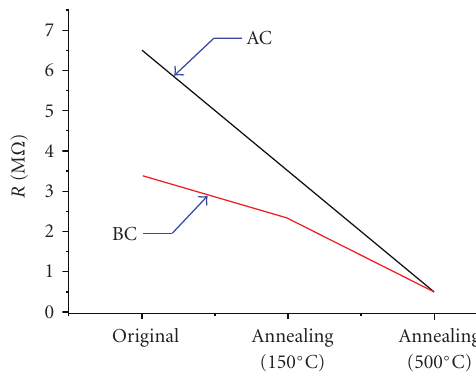
Figure 5: Schematic illustration of the reference locations for resistance